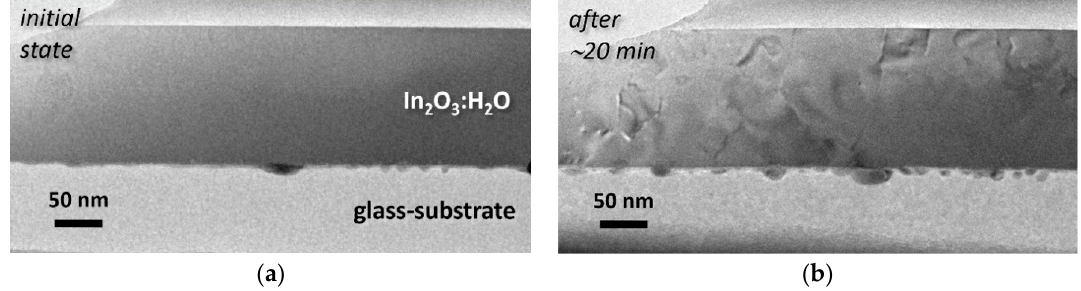
Figure 2. Brightfield TEM images of the as-deposited In 2 O 3 :H 2 O film: ( a ) first minutes of observation; ( b ) after about 20 min under the electron beam.